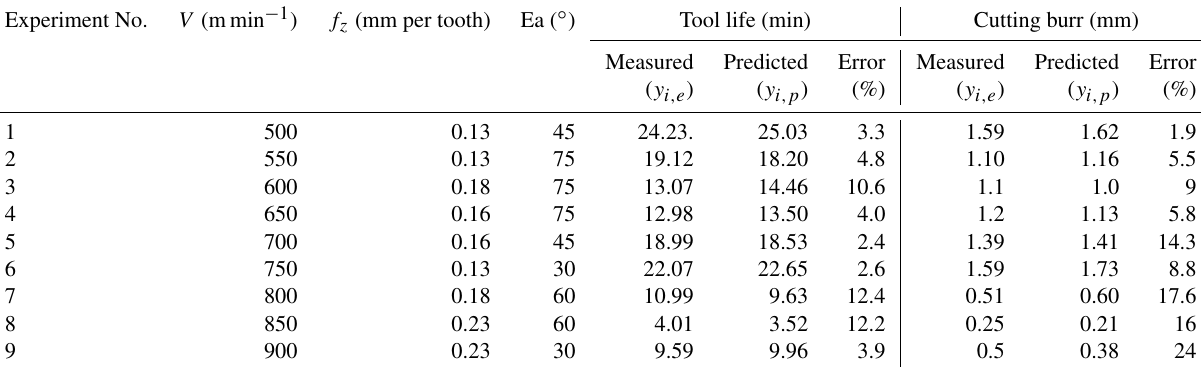
Table 6. The measured and predicted values of tool life and heights of cutting burr for testing data set. Experiment